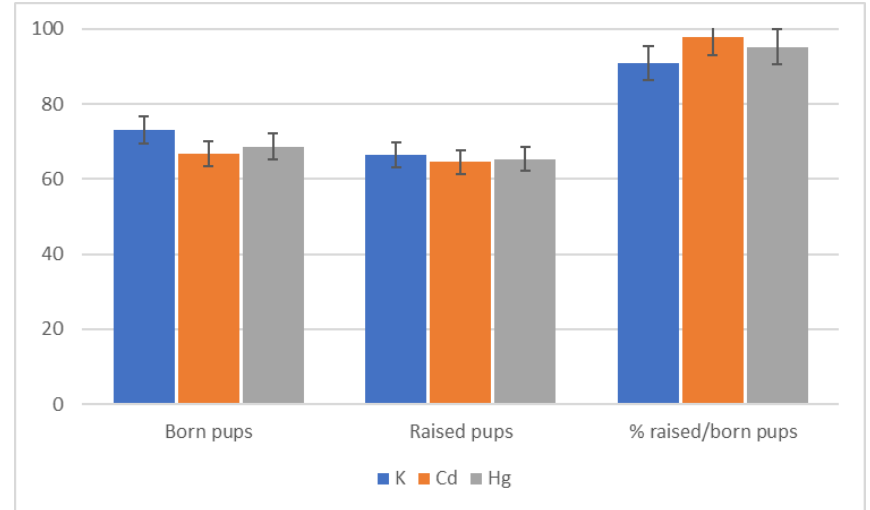
Figure 5. A comparison of average number of pups born and raised during the experiment and the percentage of raised pups out of the total number of pups. n = 8 per group.